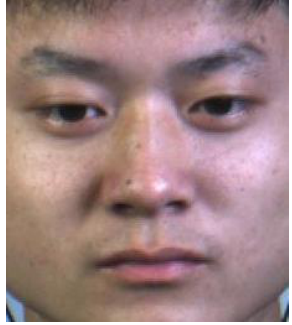
Figure 8. The cropped area.